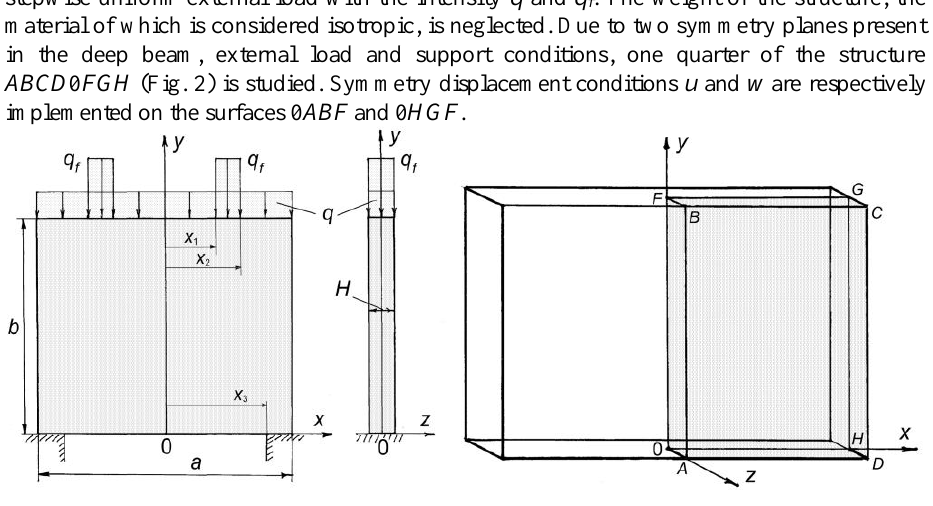
Fig. 1 . Deep beam Fig. 2. Calculation area of the deep